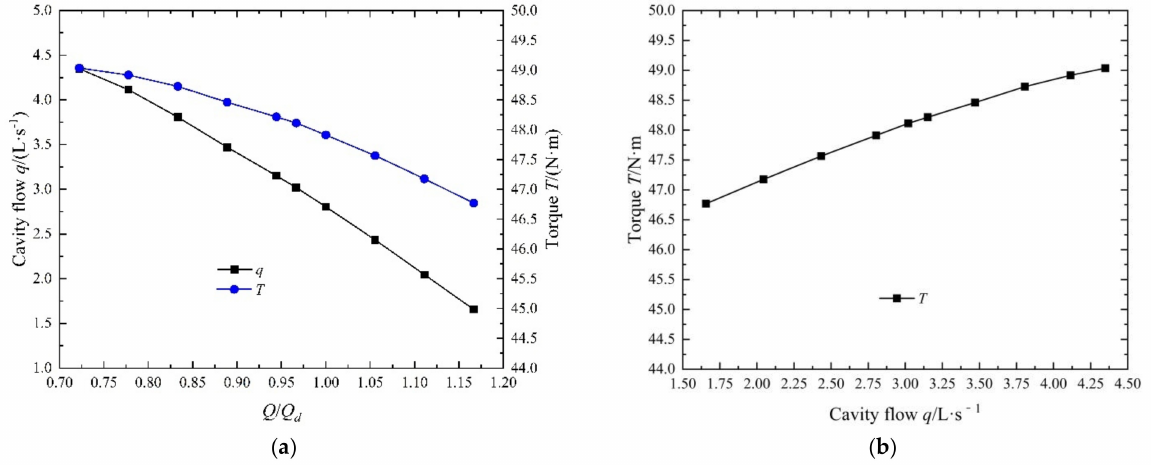
Figure 12. The cavity flow and rotor torque of the full tubular pump. ( a ) The cavity flow and rotor torque, ( b ) The relationship between torque and cavity